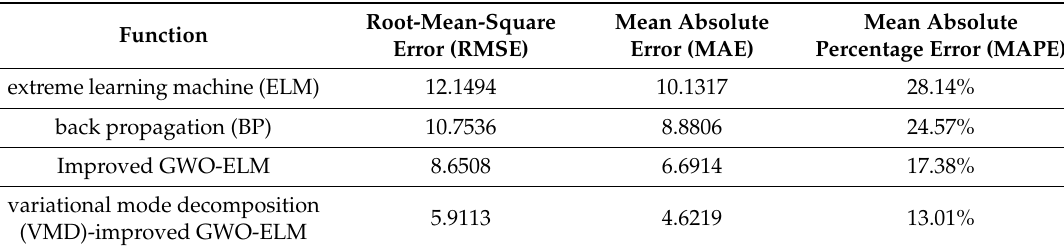
Table 3. Comparison of test